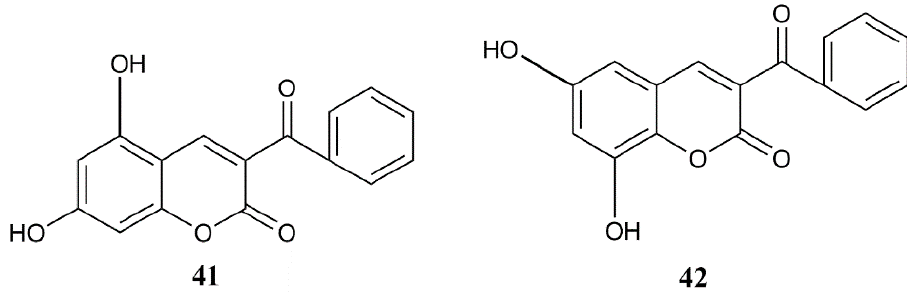
Figure 3. Structures of proposed compounds with possible enhanced inhibition of hDPP III.